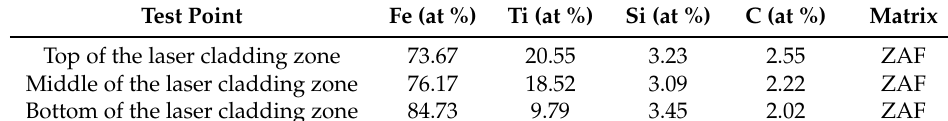
Table 2. EDS analysis data of the different parts in the laser cladding coating.